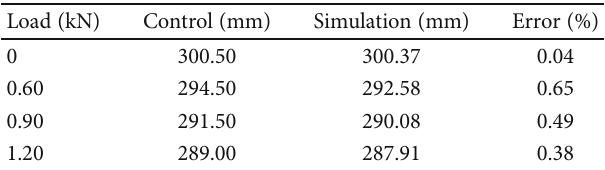
Table 1: D values at di ff erent